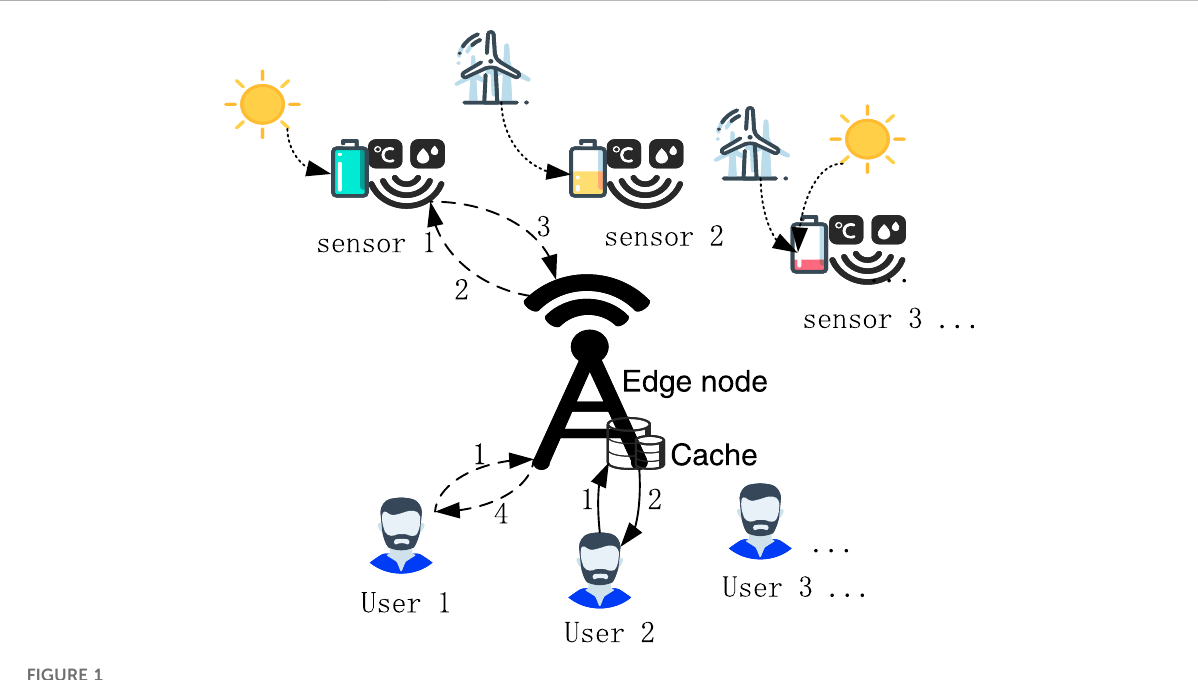
FIGURE 1 The system consists of multiple users, an edge node, and multiple energy harvesting sensors. The users make requests to the edge node. The dashedlineswithnumbersshowthattheedgenodecommandssensor1toupdateandreturntheinformationtouser1.Thesolidlineswithnumbers show that the edge node estimates the status information using cached data and returns the information to user